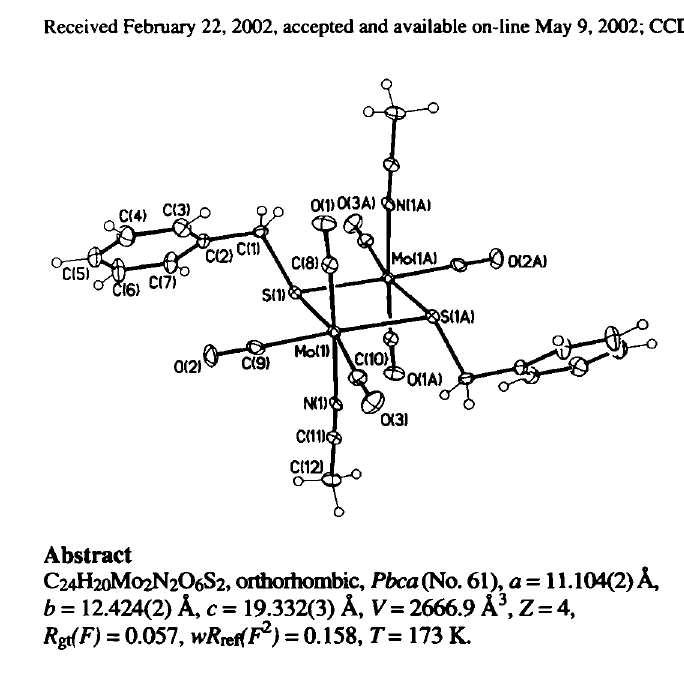
C24H20M02N2O6S2, orthorhombic, Pbca{ No. 61), a = 11.104(2) Â, b = 12.424(2) Â, c = 19.332(3) Â, V= 2666.9 Â 3 , Z = 4,